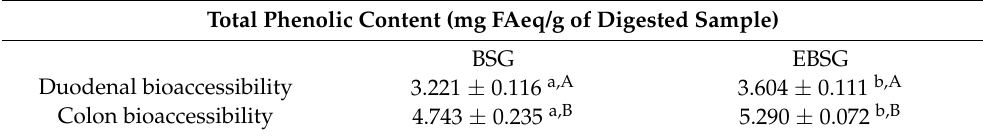
Table 3. Total polyphenolic content for BSG and EBSG intestinal- and colonic-fermented digests. Total Phenolic Content (mg FAeq/g of Digested Sample) BSG EBSG Duodenal